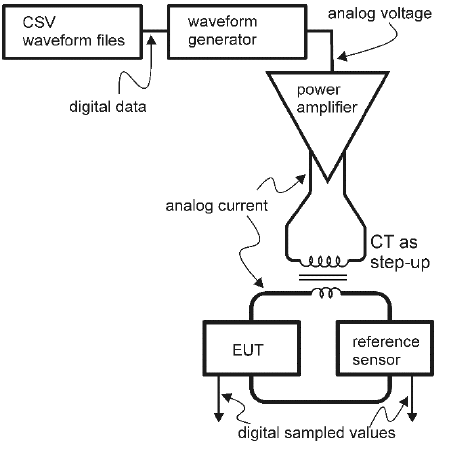
Figure 3. Experimental setup